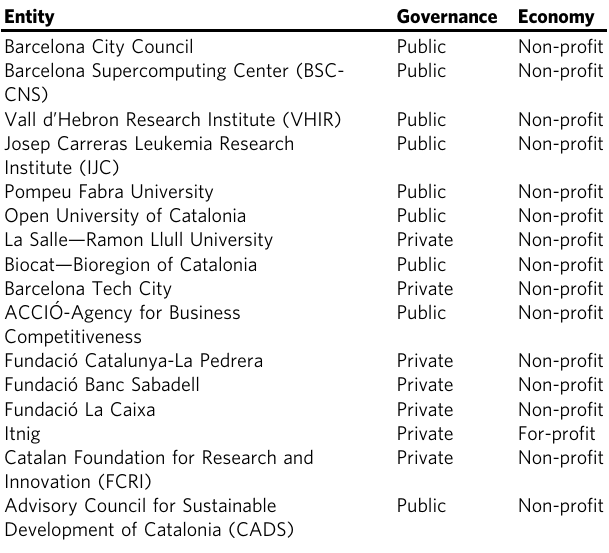
Table 1 Institutions comprising the Ecosystem Board of SciTech DiploHub — Barcelona Science and Technology Diplomacy